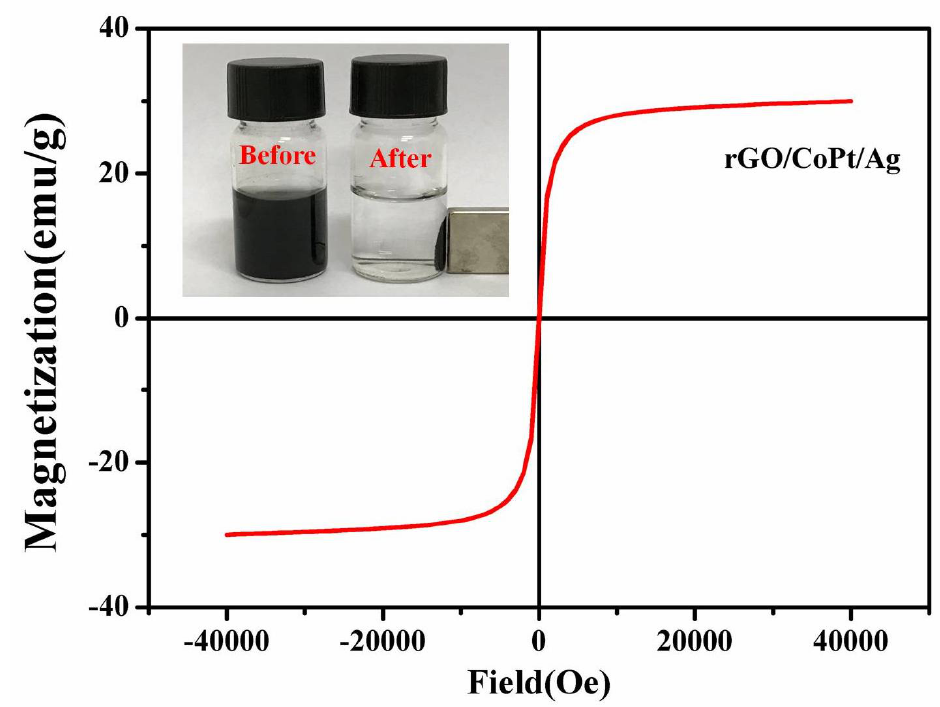
Figure 6. Hysteresis loop of rGO/CoPt/Ag at room temperature.